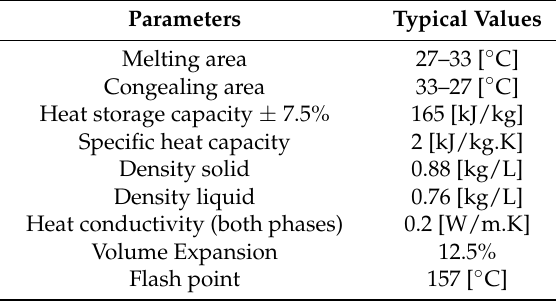
Table A1. Properties of the PCM-RT31 [57].